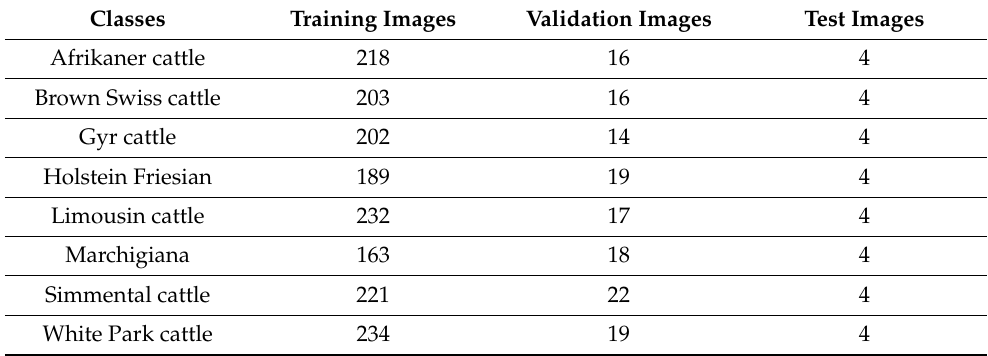
Table 2. Dataset